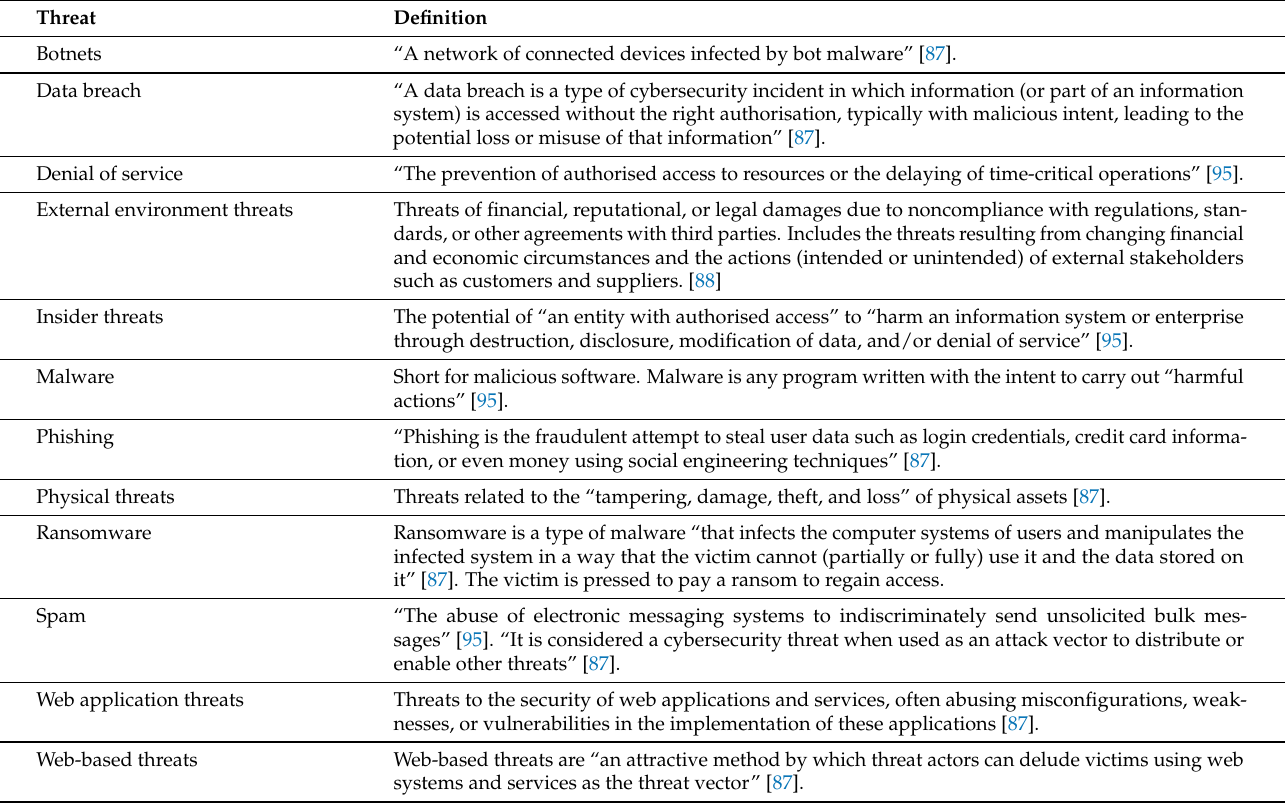
Table A1. Definitions of threats, based on ENISA [87], NIST [95], and van Haastrecht et al. [88]